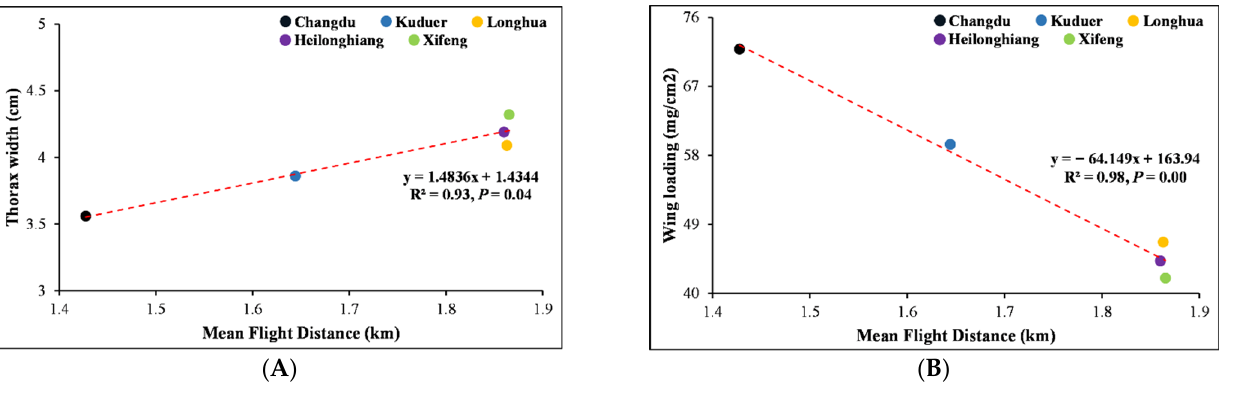
Figure 7. Association of body size with the flight ability of female L. dispar asiatica : ( A ) Correlation between female thorax width and female flight capability; ( B ) Correlation between female thorax width and female flight capability. Table 6. Evaluation of body size between female Asian spongy moth ( L. dispar asiatica ) populations from five different geographical locations in China. Values are presented as Mean ± SE.